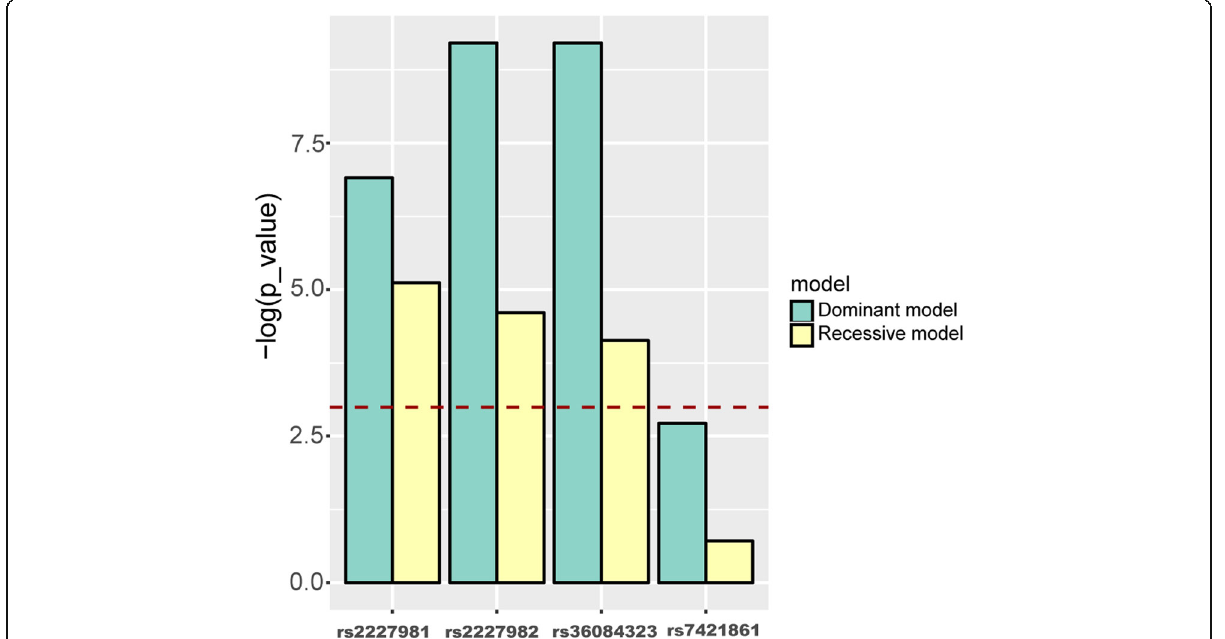
Fig. 3 P _value of logistic regression model under dominant and recessive models. The dashed red line indicates the significance threshold ( p _value = 0.05)